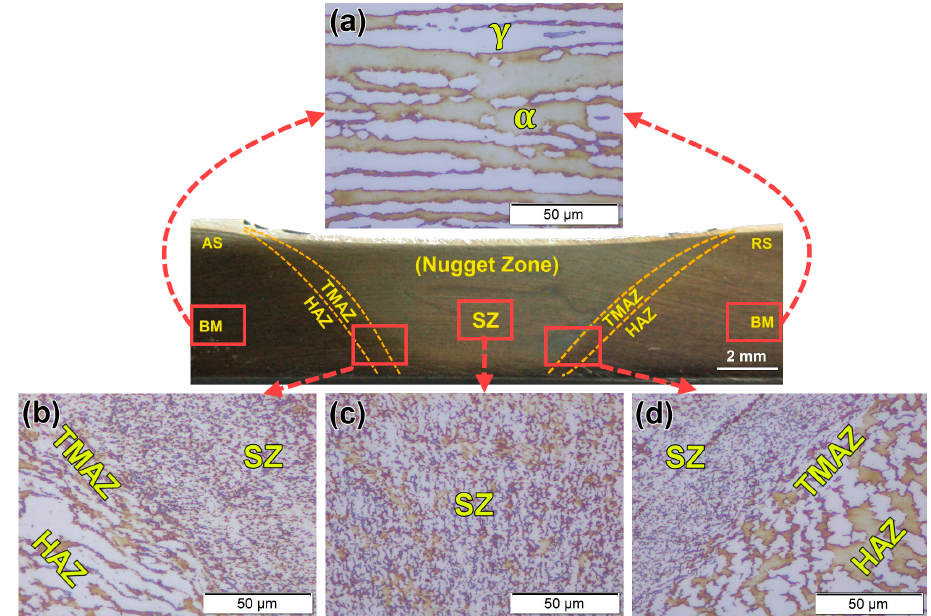
Figure 9. Optical microstructure of the FSWed 2205 DSS butt joint using the V-shaped groove with root face: ( a ) BM, ( b ) SZ/TMAZ/HAZ on the advanced side, ( c ) SZ, and ( d ) SZ/TMAZ/HAZ on the retreating side.